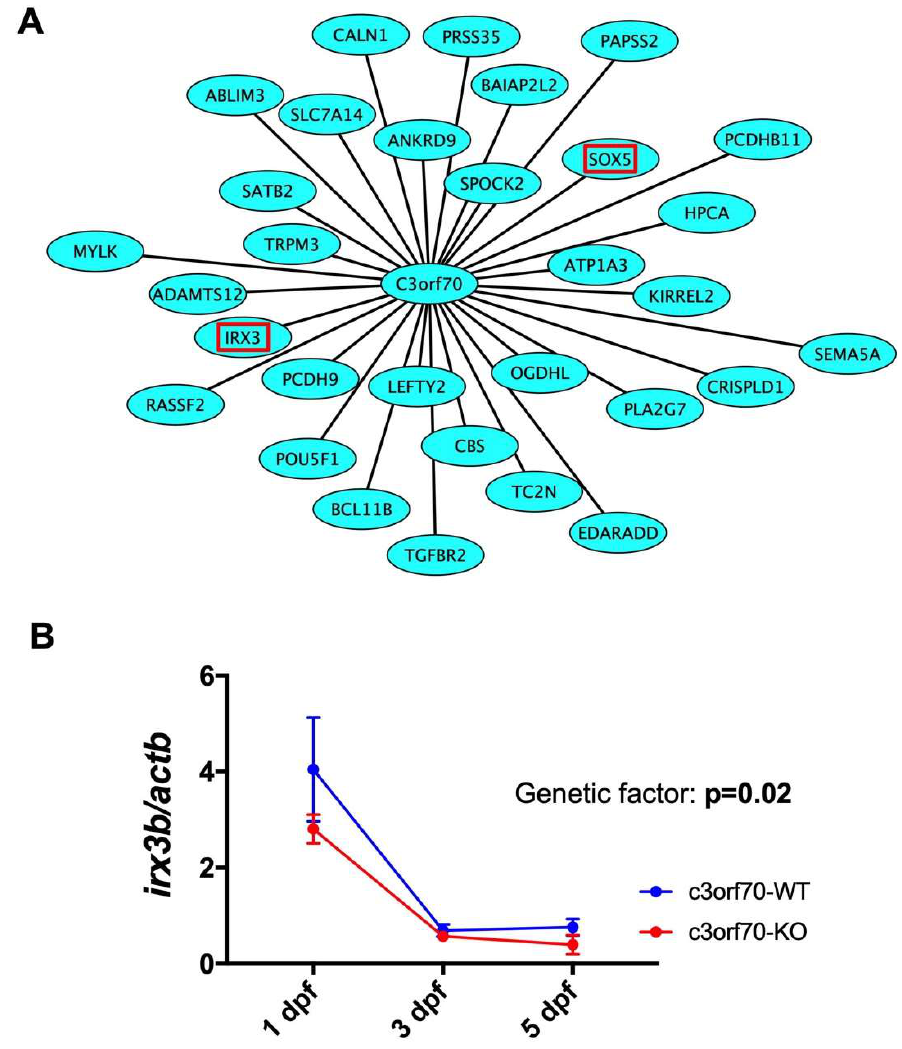
Figure 5. Weighted gene coexpression network analysis (WGCNA) identifies IRX3 as a gene coexpressed with C3orf70 during neurogenesis. ( A ) Schematic showing the 31 genes coexpressed with C3orf70 in human stem cells overexpressing Neurog1 / 2 (GSE60548) [13] and mouse stem cells overexpressing Ascl1 (GSE43971) [12], as identified by WGCNA. IRX3 and SOX5 are outlined in red. ( B ) qPCR analysis of irx3b expression in c3orf70-WT and KO zebrafish. Data are presented as the mean ± SEM of n = 3.